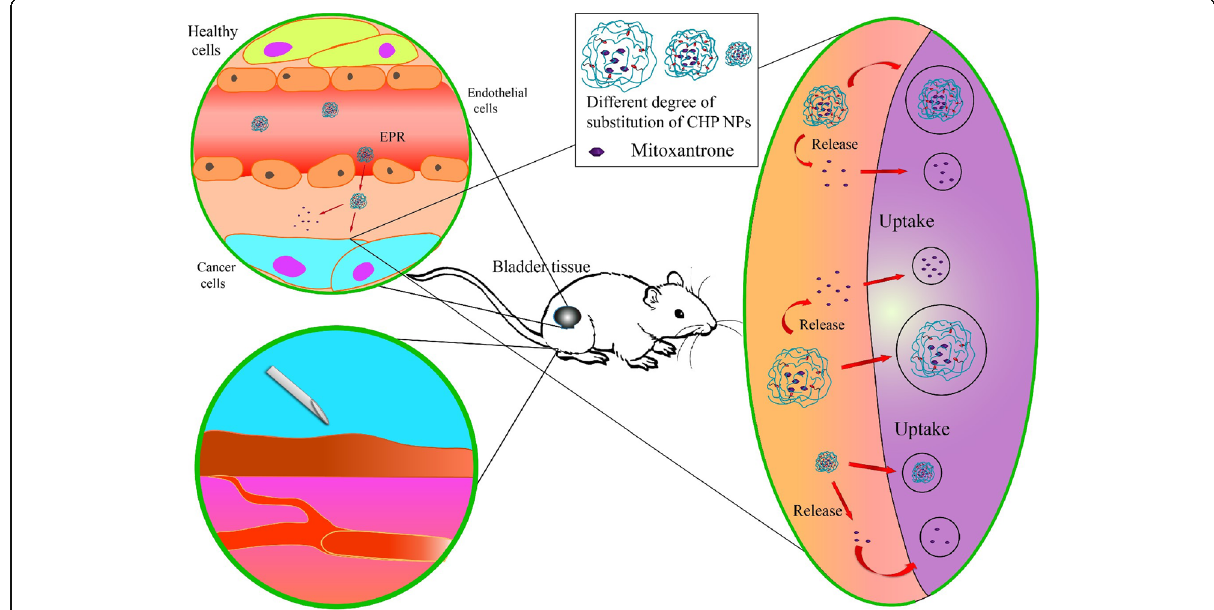
Fig. 9 The treatment efficacy of mitoxantrone-loaded CHP NPs by mainly location release in tumor tissue